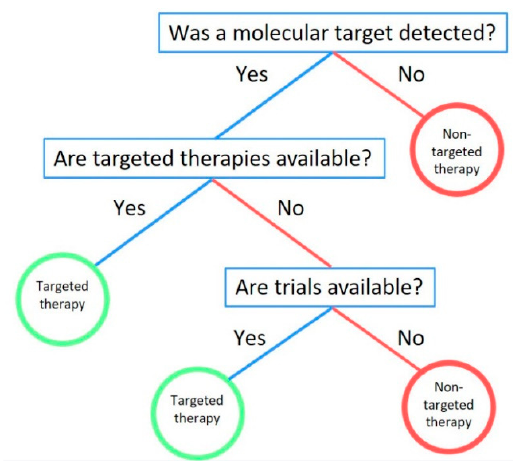
Figure 3. Comprehensive fast-and-frugal decision tree for lung cancer. A comprehensive molecular fast-and-frugal tree for stage IV lung cancer decision-making.